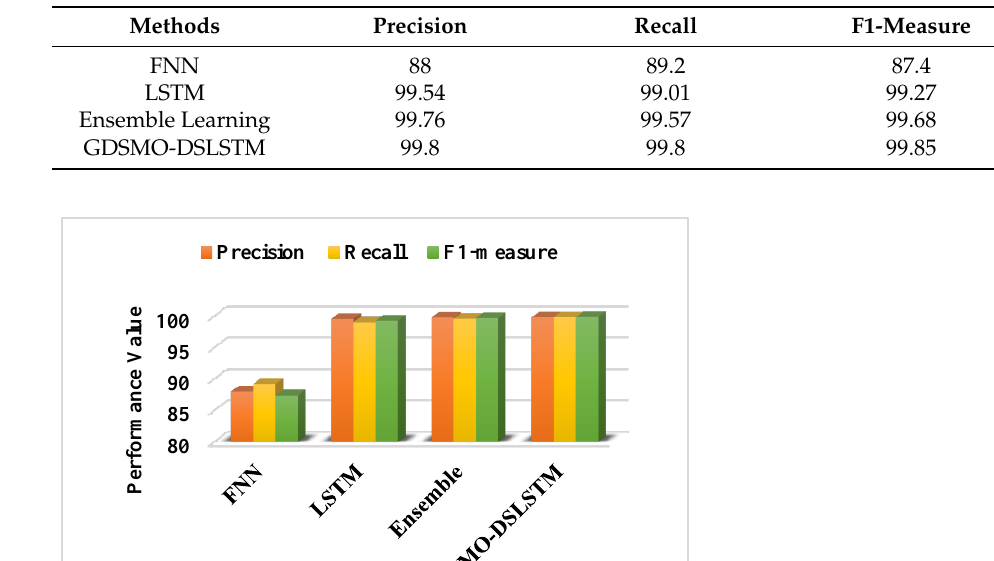
Table 8. Precision, recall and f1-measure of existing and proposed classification techniques.